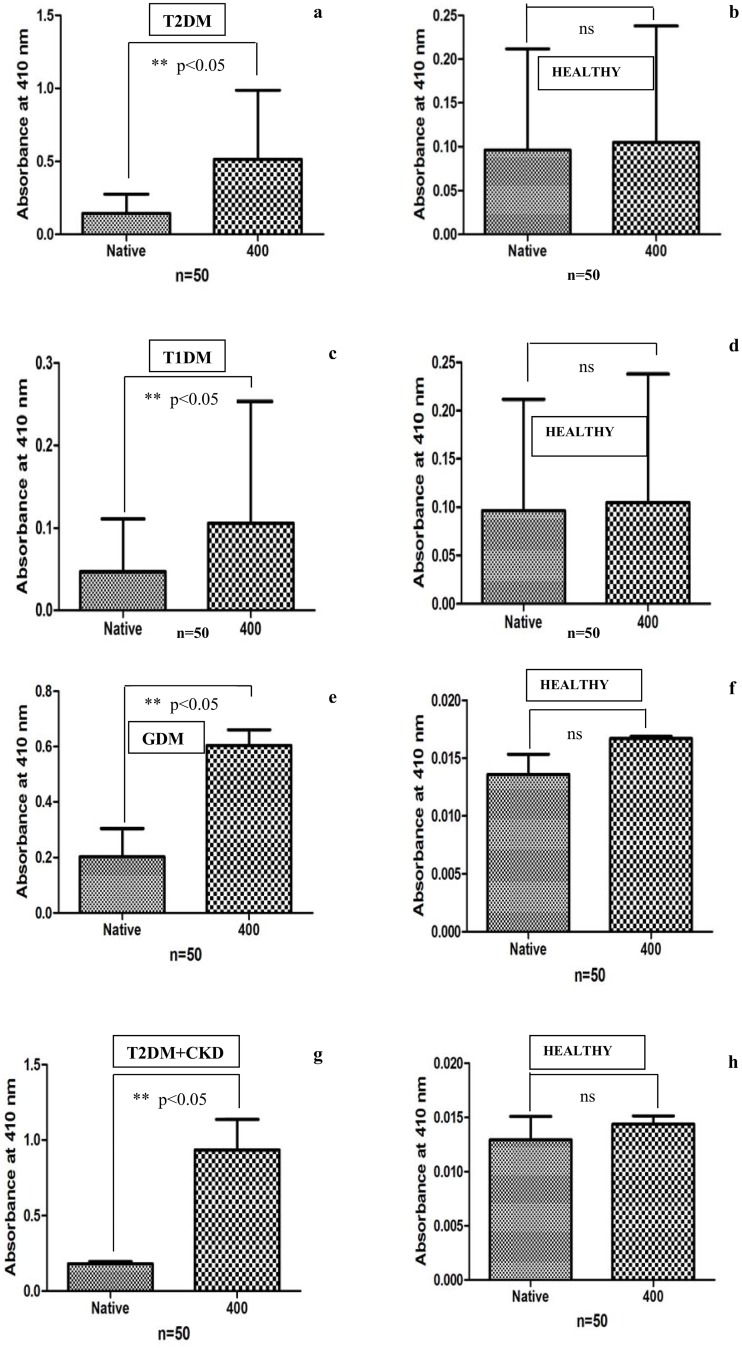
Direct binding ELISA of serum auto-antibodies in (a) T2DM (n = 50) (c) T1DM (n = 50) (e) GDM (n = 50) (g) T2DM+CKD (n = 50) with native and 400 mg/dL glucose modified HSA and normal human sera (NHS) served as control in (b) (n = 50), (d) (n = 50), (f) (n = 50) and (h) (n = 50).The plate was coated with the respective antigens (10μg/mL). A p value <0.05 considered to be significant. ns = non-significant